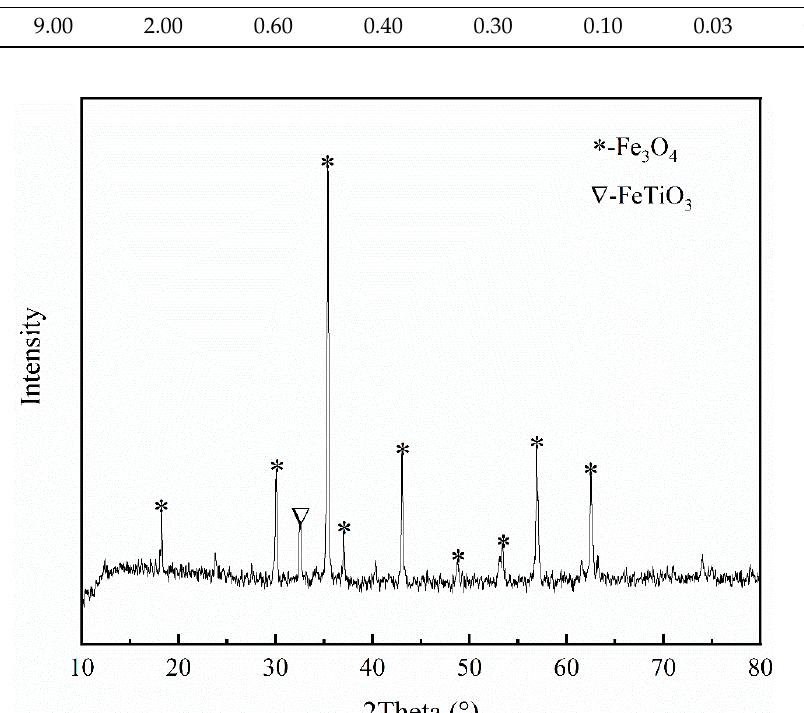
Figure 2. XRD pattern of V-Ti magnetite